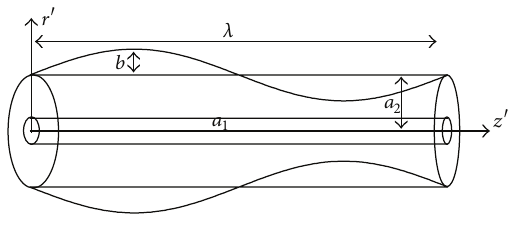
Figure 1: Geometry of the